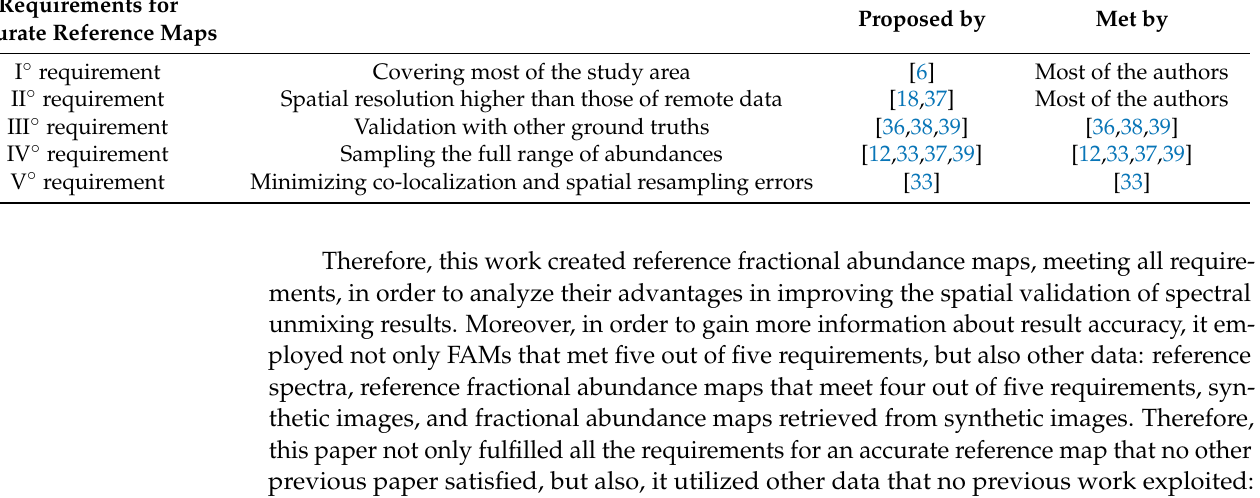
Table 1. Requirements for accurate reference maps.